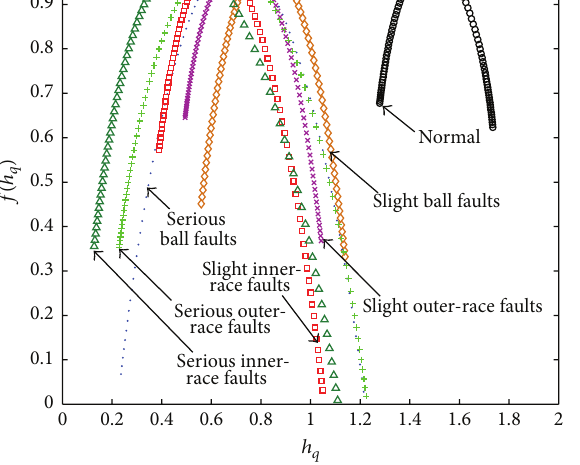
Figure 6: The multifractal spectrum.